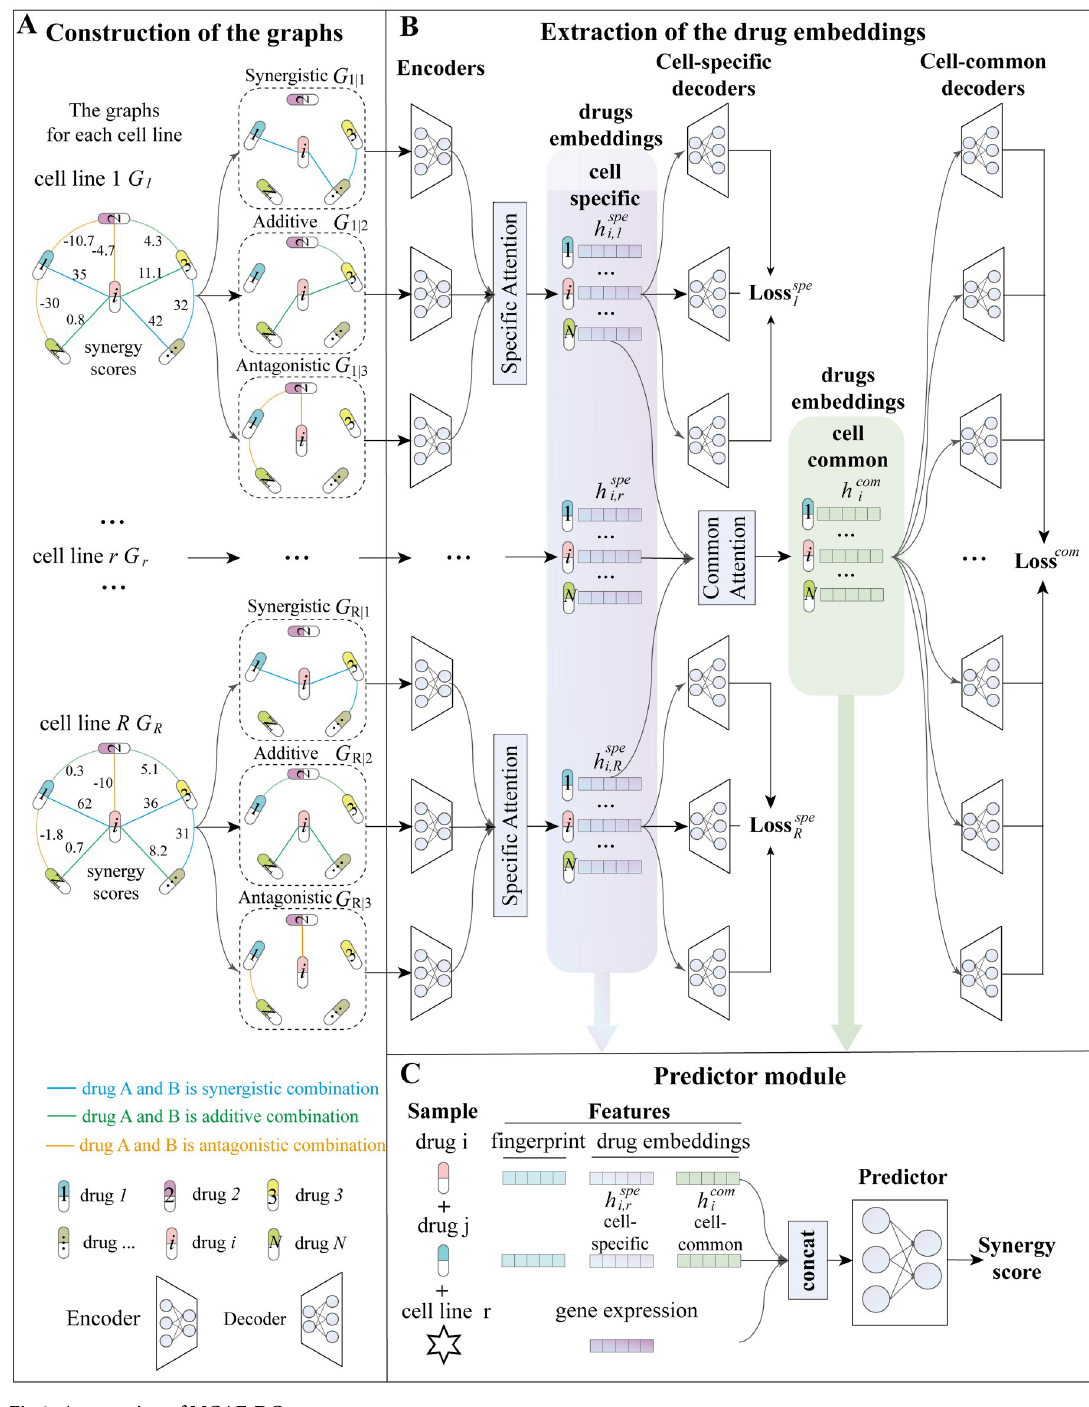
Fig 1. An overview of MGAE-DC.